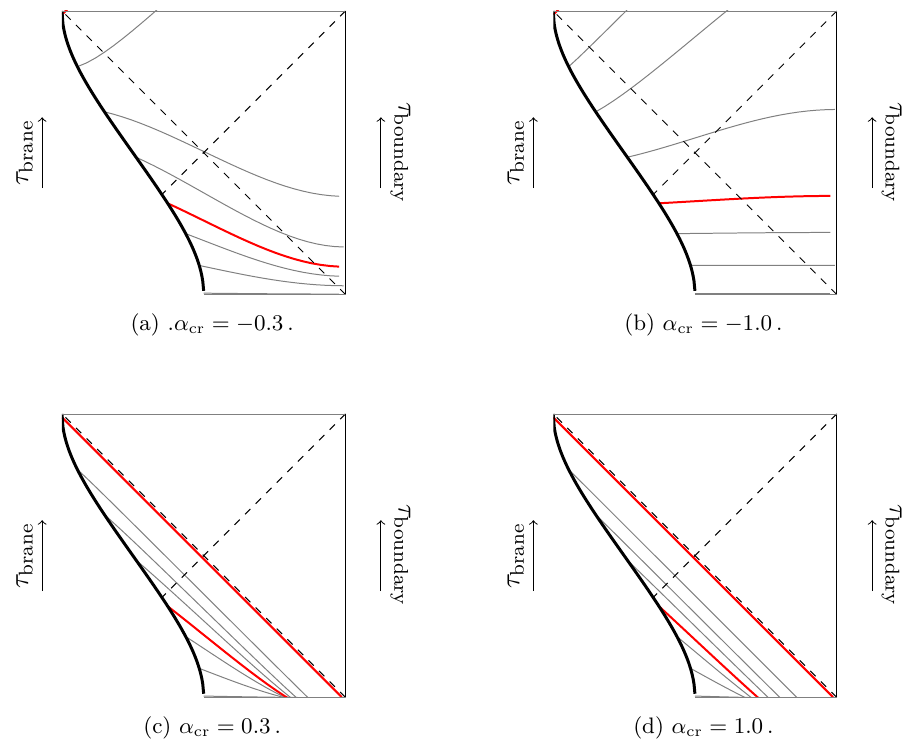
Figure 10 . A family of extremal surfaces emanating from the brane for the critical case. The red surfaces start at y = 0 . 4 and y = 1 . 57 on the brane. (a) and (b) indicate that for α cr < 0 − − π extremal surfaces can end on the asymptotic boundary at τ boundary > . (c) and (d) show that for 2 − α cr > 0 there are no extremal surfaces connecting the brane with the asymptotic boundary within the same coordinate